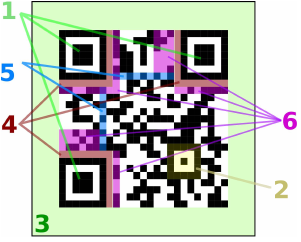
Figure 3. Topology of a QR